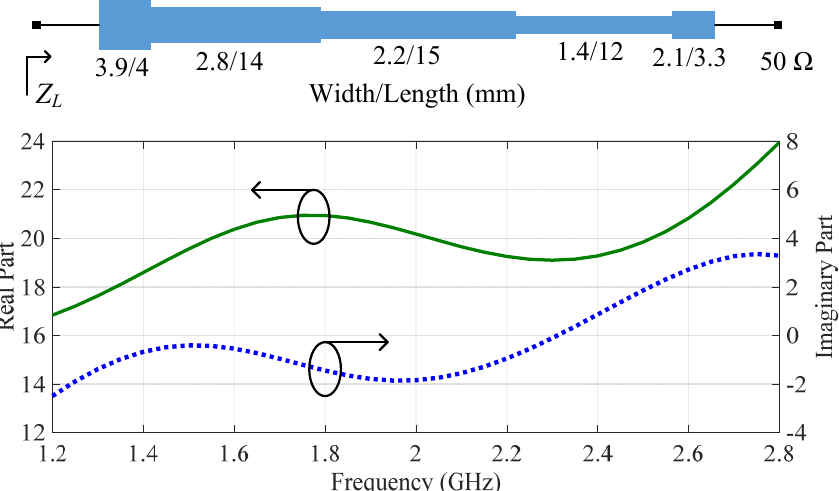
Figure 5. Schematic of the designed PMN and its simulation results.